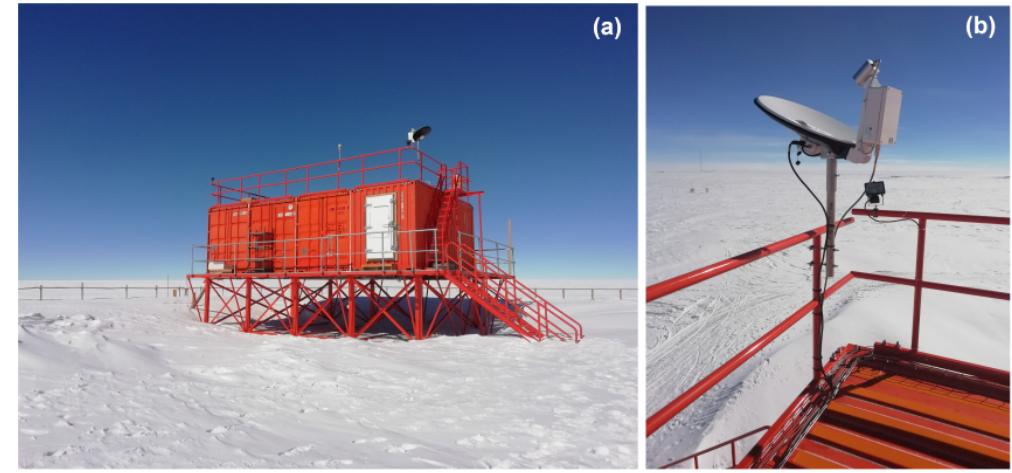
Figure 2. (a) PHYSICS shelter at Concordia station. (b) Micro rain radar (MRR) installed in 2018 on the roof of the